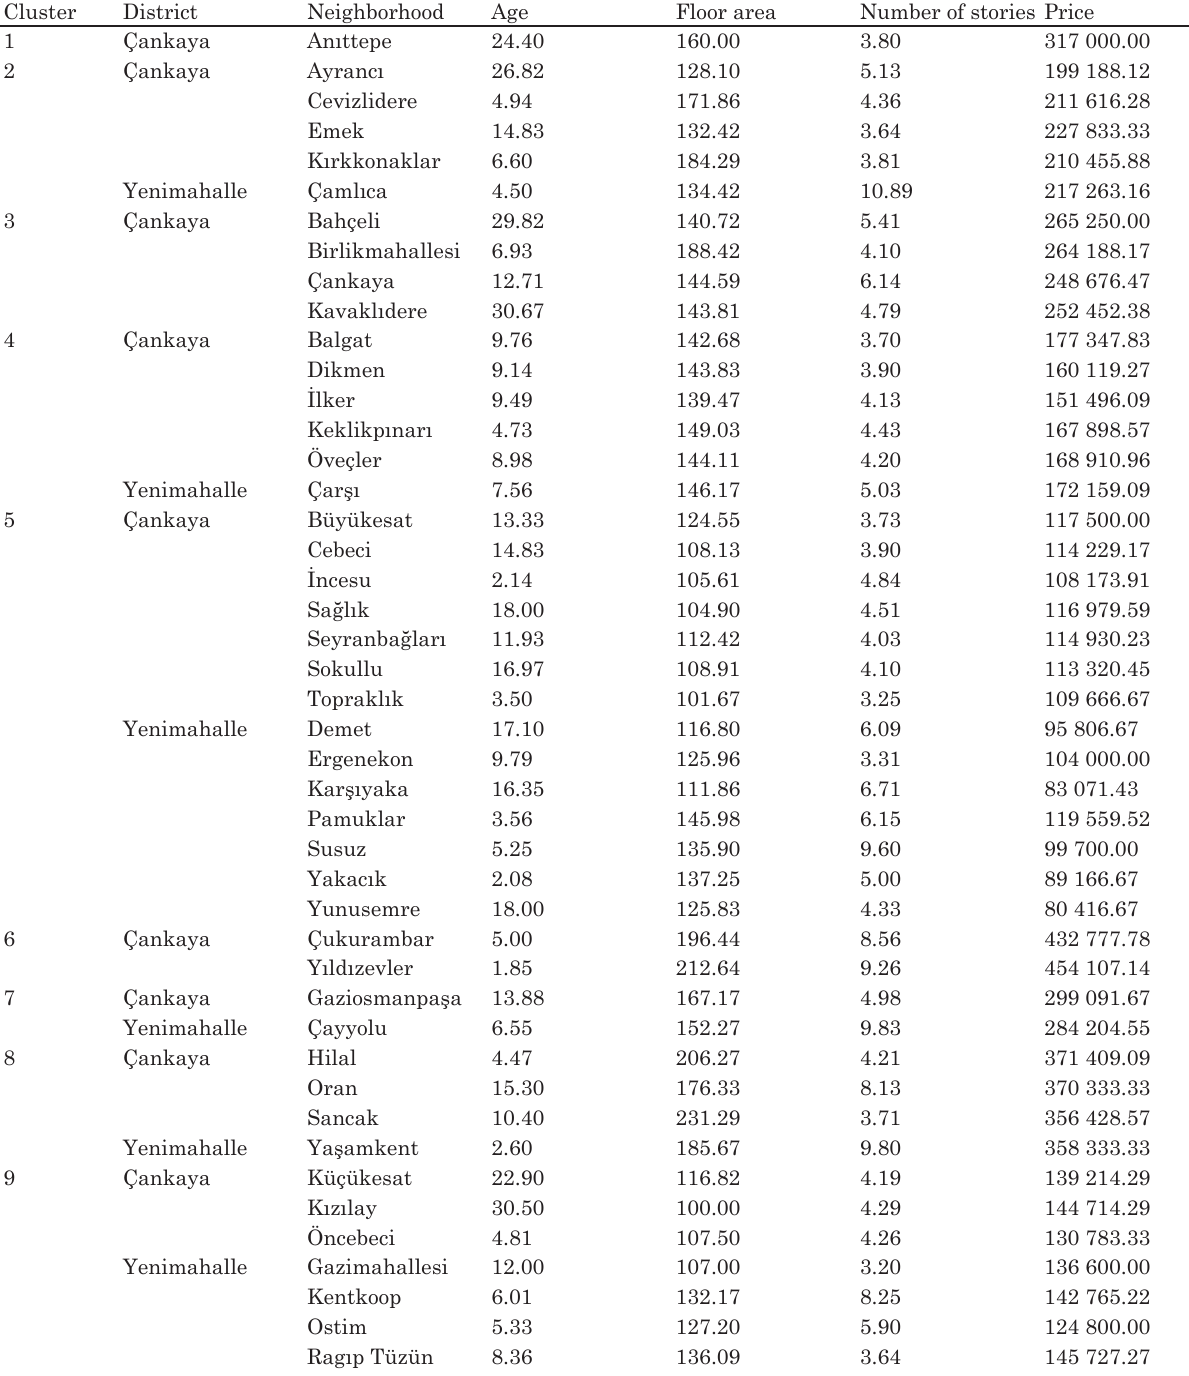
Table 9. Residential characteristics of neighborhoods Cluster